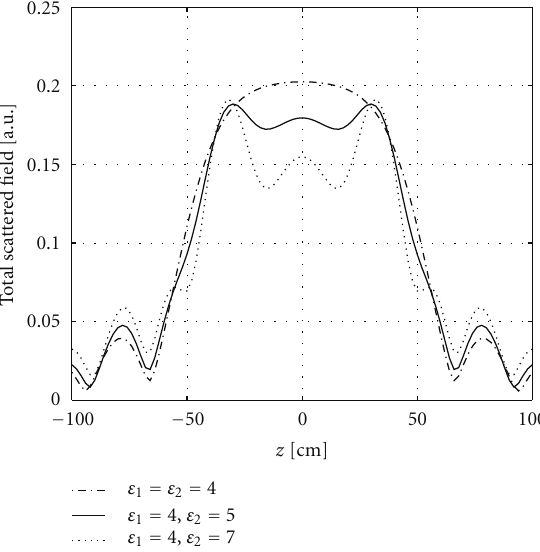
Figure 5: Total scattered field in air, along a line parallel to the interface, for the layout of Figure 4, with L = 120